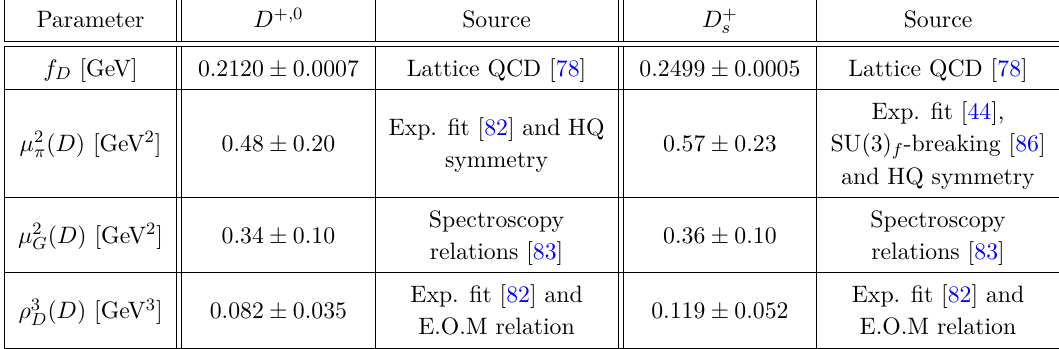
Table 16 . Numerical values of the non-perturbative parameters used in our analysis.